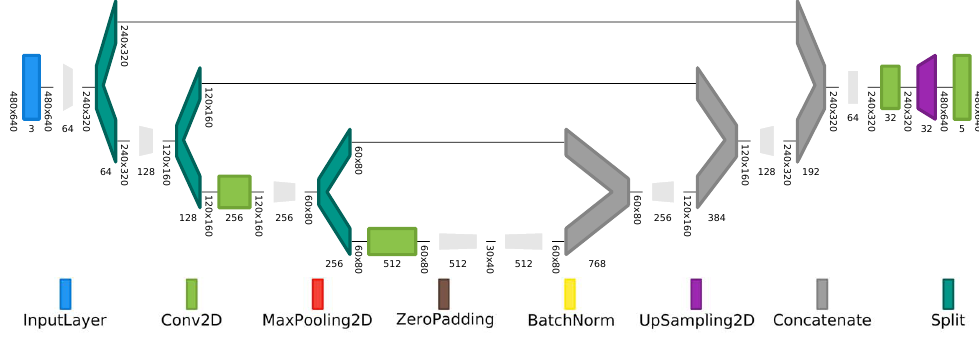
Figure 6. VGG–UNet for vein segmentation.